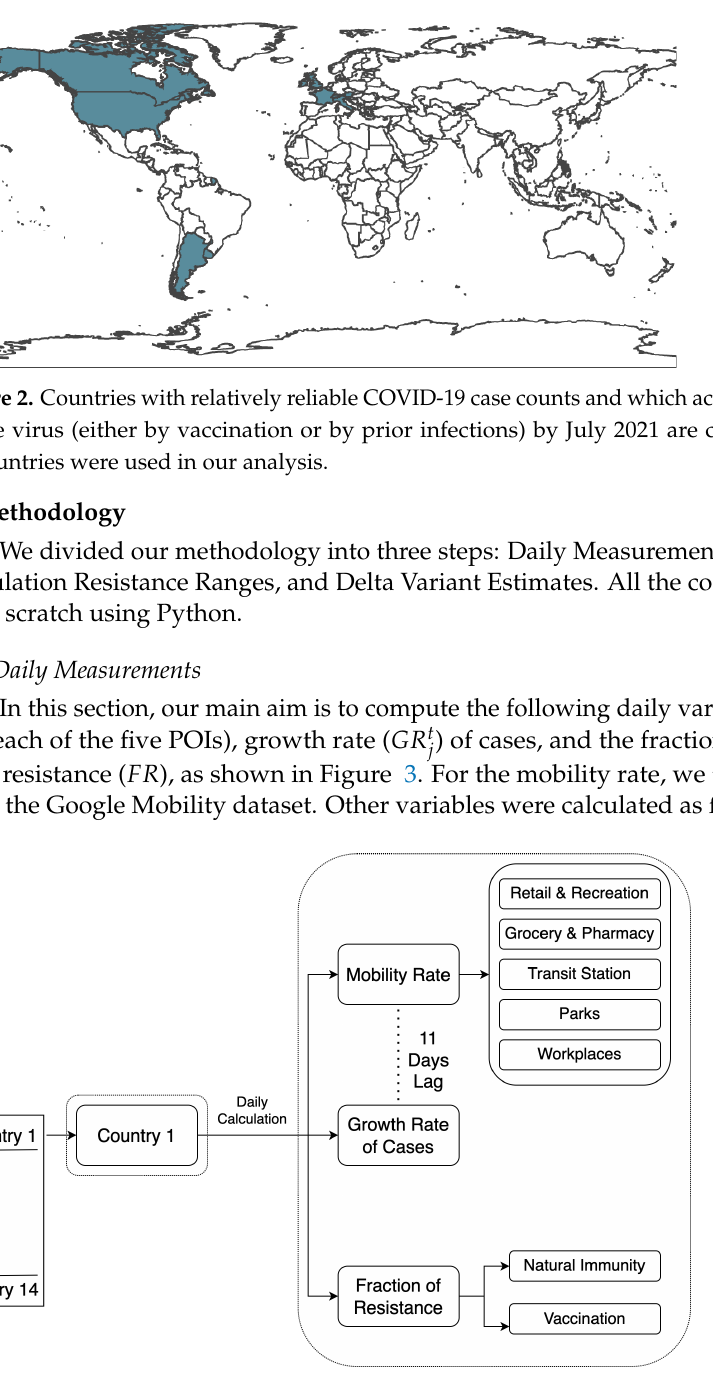
Figure 3. Flowchart showing the daily measurements calculated for each of the 14 countries, including mobility rate for the five POIs, the growth rate of cases with 11 days lag, and the fraction of resistance based on natural immunity and